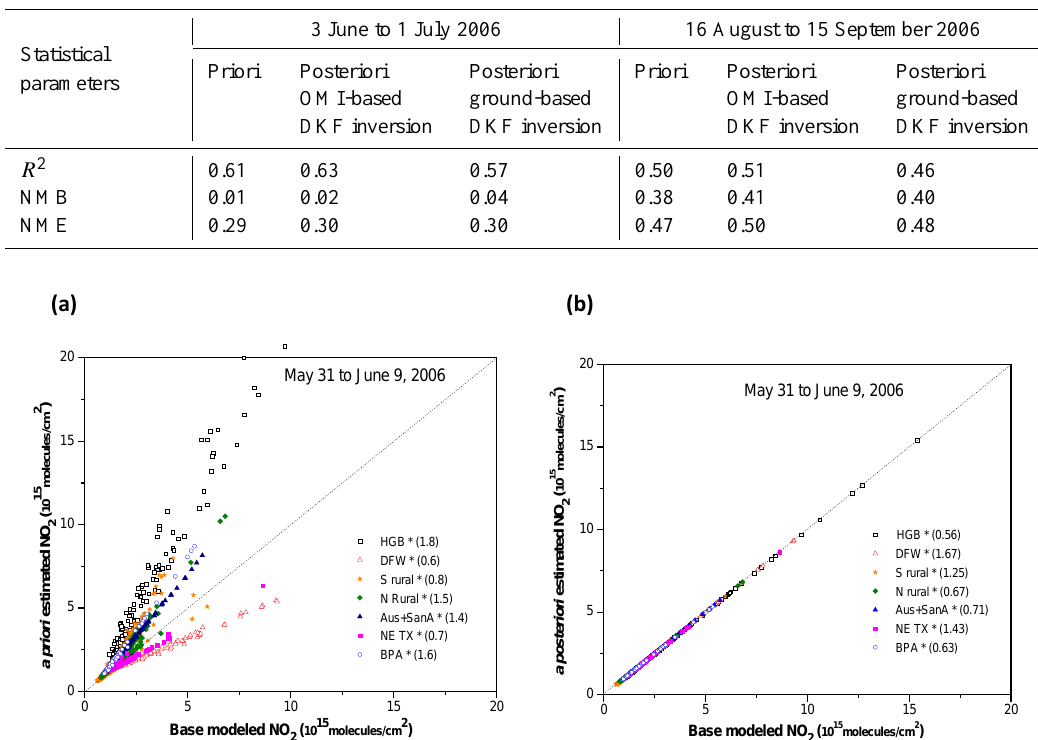
Fig. 3. Pseudodata test showing that the DKF inversion accurately adjusts the NO x emissions from the perturbed case (a) to the a posteriori case (b) to match the desired base NO 2 column densities. Numbers indicate perturbation factors in the legend (a) and adjustment factors in the legend (b) . Similar performance is found for the 13–22 August test